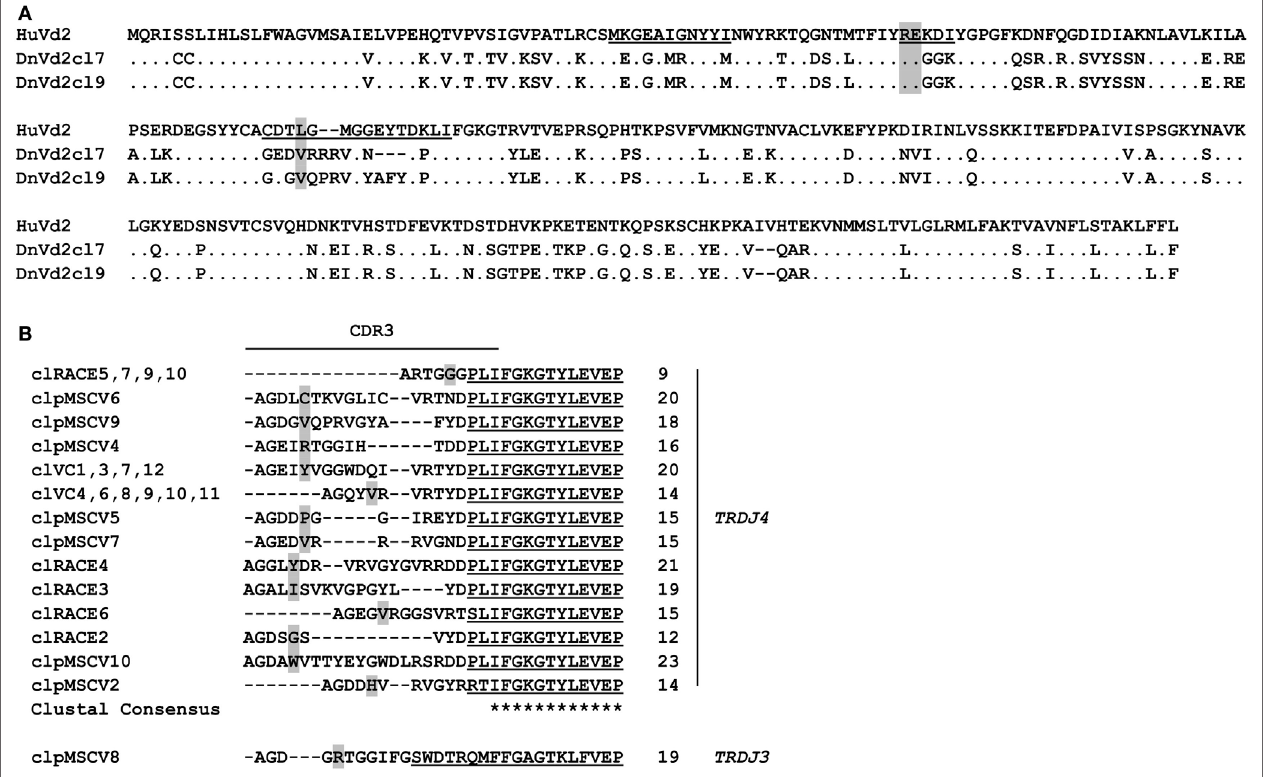
FigUre 2 | In silico translatable V δ 2 T cell receptor chains are expressed in Dasypus novemcinctus PBMCs. (a) Alignment of human G115 V δ 2 chain (PDB: 1HXM_A) (30) and two representative armadillo V δ 2 chains (obtained from cloning of full-length armadillo V δ 2 chains into pMSCV-IRES-mCherry FP). CDR regions appear underscored and positions δ 51/52 and δ 97 (gray) are highlighted. (B) CDR3 regions of TRDV2 clones obtained by TRDV2/TRDC PCR (clVC1, 3, 4, and 6–12), TRDV2 3 ′ RACE PCR (cl2-7, 9, 10), and cloning (clpMSCV2, 4–10). CDR3 lengths and TRDJ-usage are indicated on the right. Alignments were calculated with Clustal Omega webtool, identical amino acids (dots), J region (underscored), and positions δ 51/52 and δ 97 (gray) are highlighted. The GenBank Accession numbers of unique clones are: cl2 (MG021118); clVC1 (MG021131); clVC4 (MG021132); cl3 (MG021127); cl4 (MG021128); cl5 (MG021129); cl6 (MG021130); clpMSCV2 (MG807648); clpMSCV4 (MG807649); clpMSCV5 (MG807650); clpMSCV6 (MG807651); clpMSCV7 (MG807652); clpMSCV8 (MG807653); clpMSCV9 (MG807654); clpMSCV10